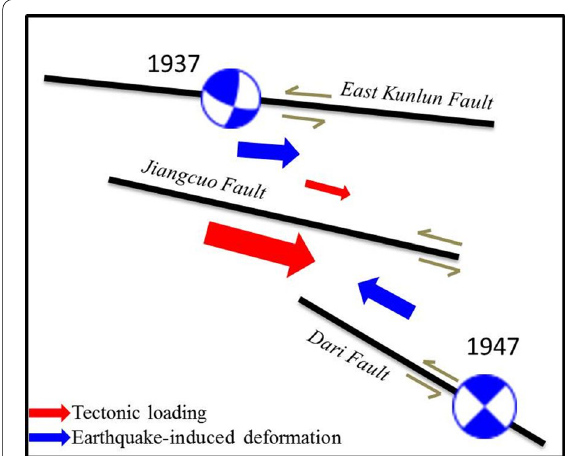
Fig. 4 The sketch map of the impact of two earthquakes and the tectonic activity